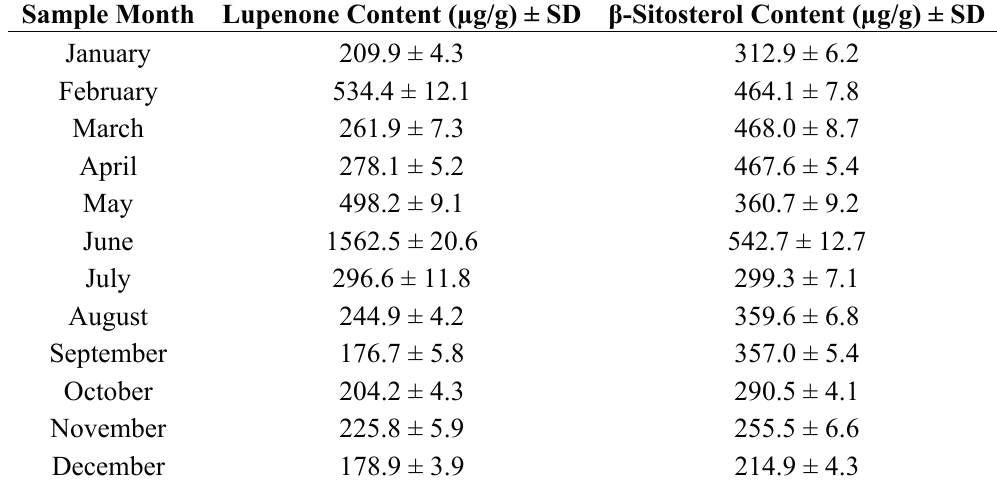
Table 5. Lupenone and β -sitosterol levels at different harvest times of Rhizoma Musae sample collection.